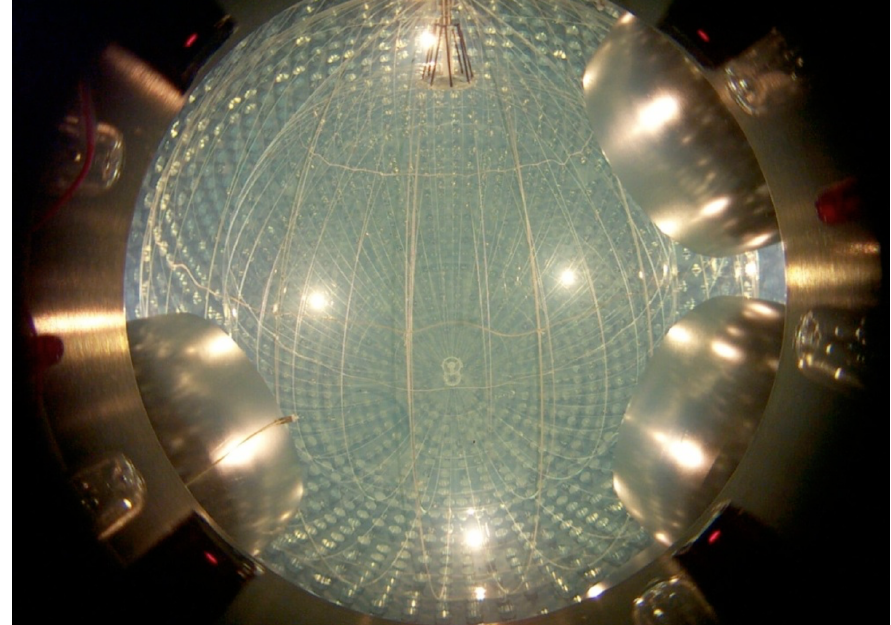
Figure 3: The Borexino inner detector filled with scintillator in